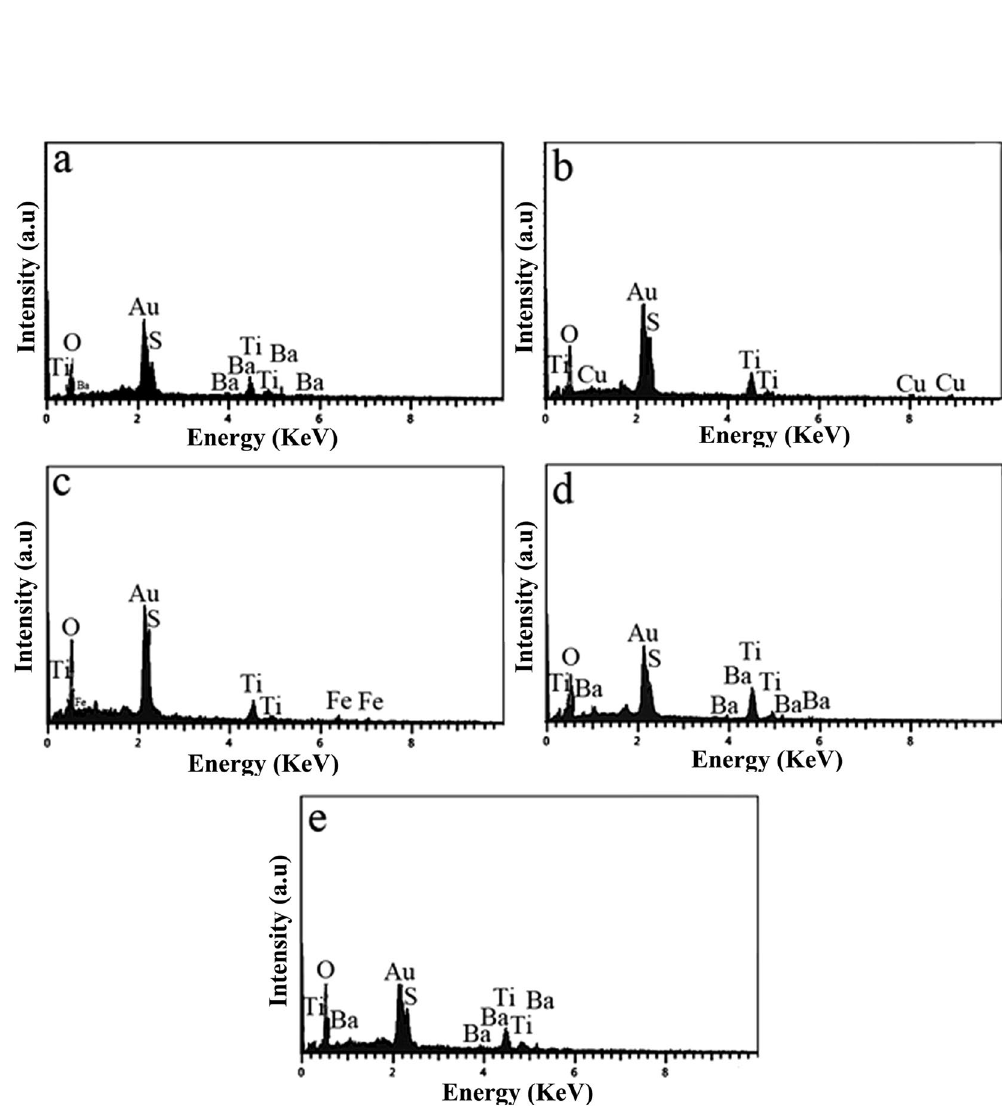
Figure 2. EDX for ( a ) BaSO 4 –BaTiO 3 , ( b ) Cu–BaSO 4 –BaTiO 3 , ( c ) Fe–BaSO 4 –BaTiO 3 , ( d ) N–BaSO 4 –BaTiO 3 and ( e )